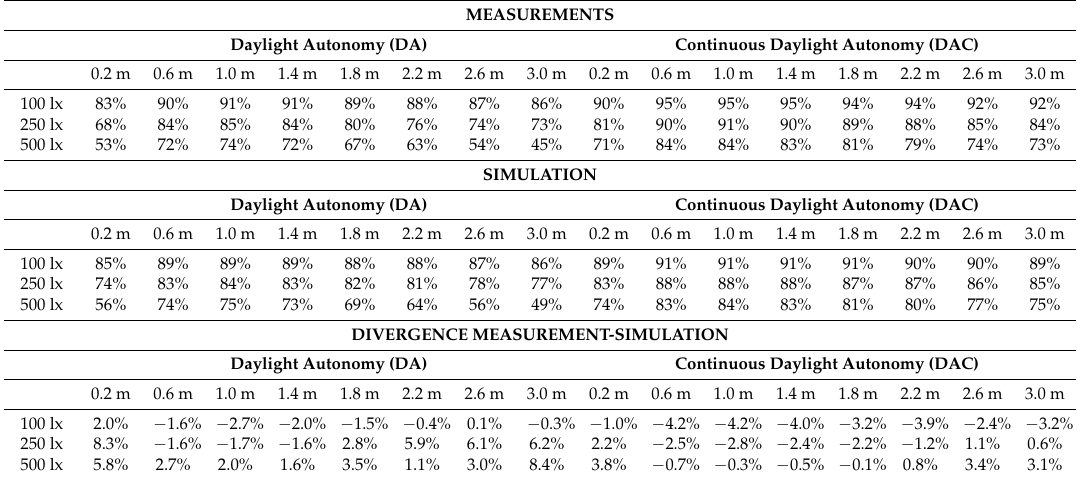
Table 5. DA and DAC values obtained for test cell illuminance measurements and for model simulation